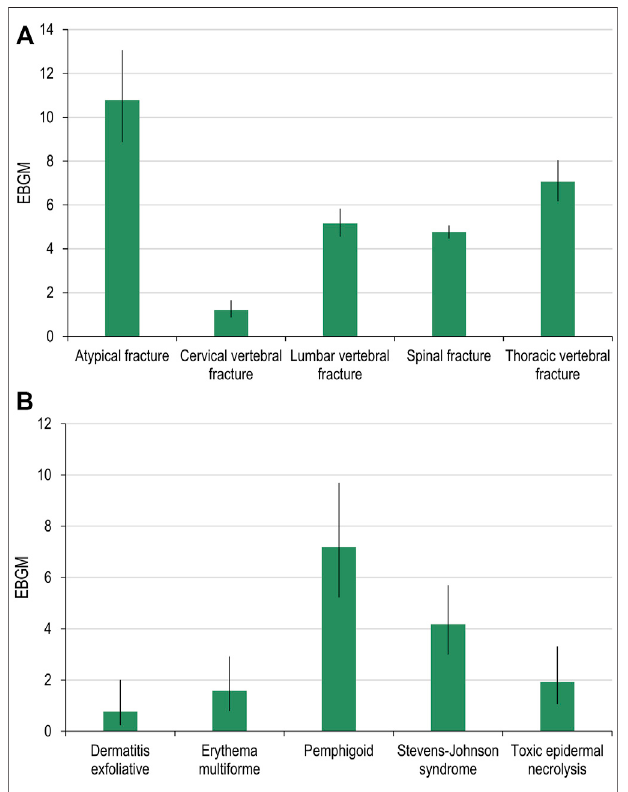
FIGURE 2 | Adverse events of speci fi c interest for denosumab (A) and pembrolizumab (B) detected in FAERS. FAERS, Food and Drug Administration Adverse Event Reporting System; EBGM, empirical Bayes geometric mean.